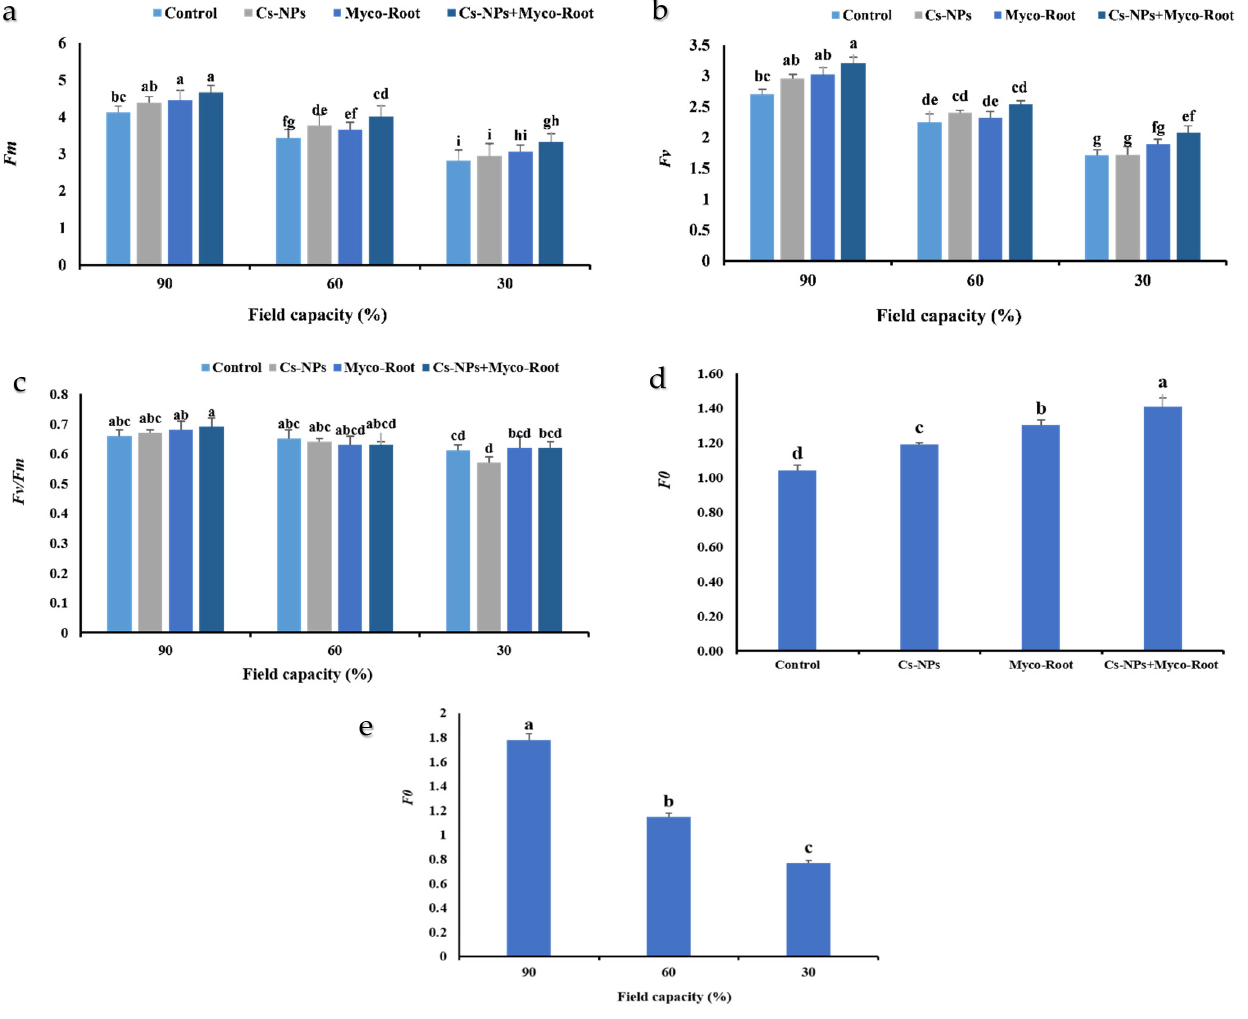
Figure 2. The F m ( a ), F v ( b ), F v / F m ( c ) and F 0 ( d , e ) values of L. iberica in different fertilizer sources and irrigation levels. Different letters indicate significant differences at the 5% level according to LSD test.